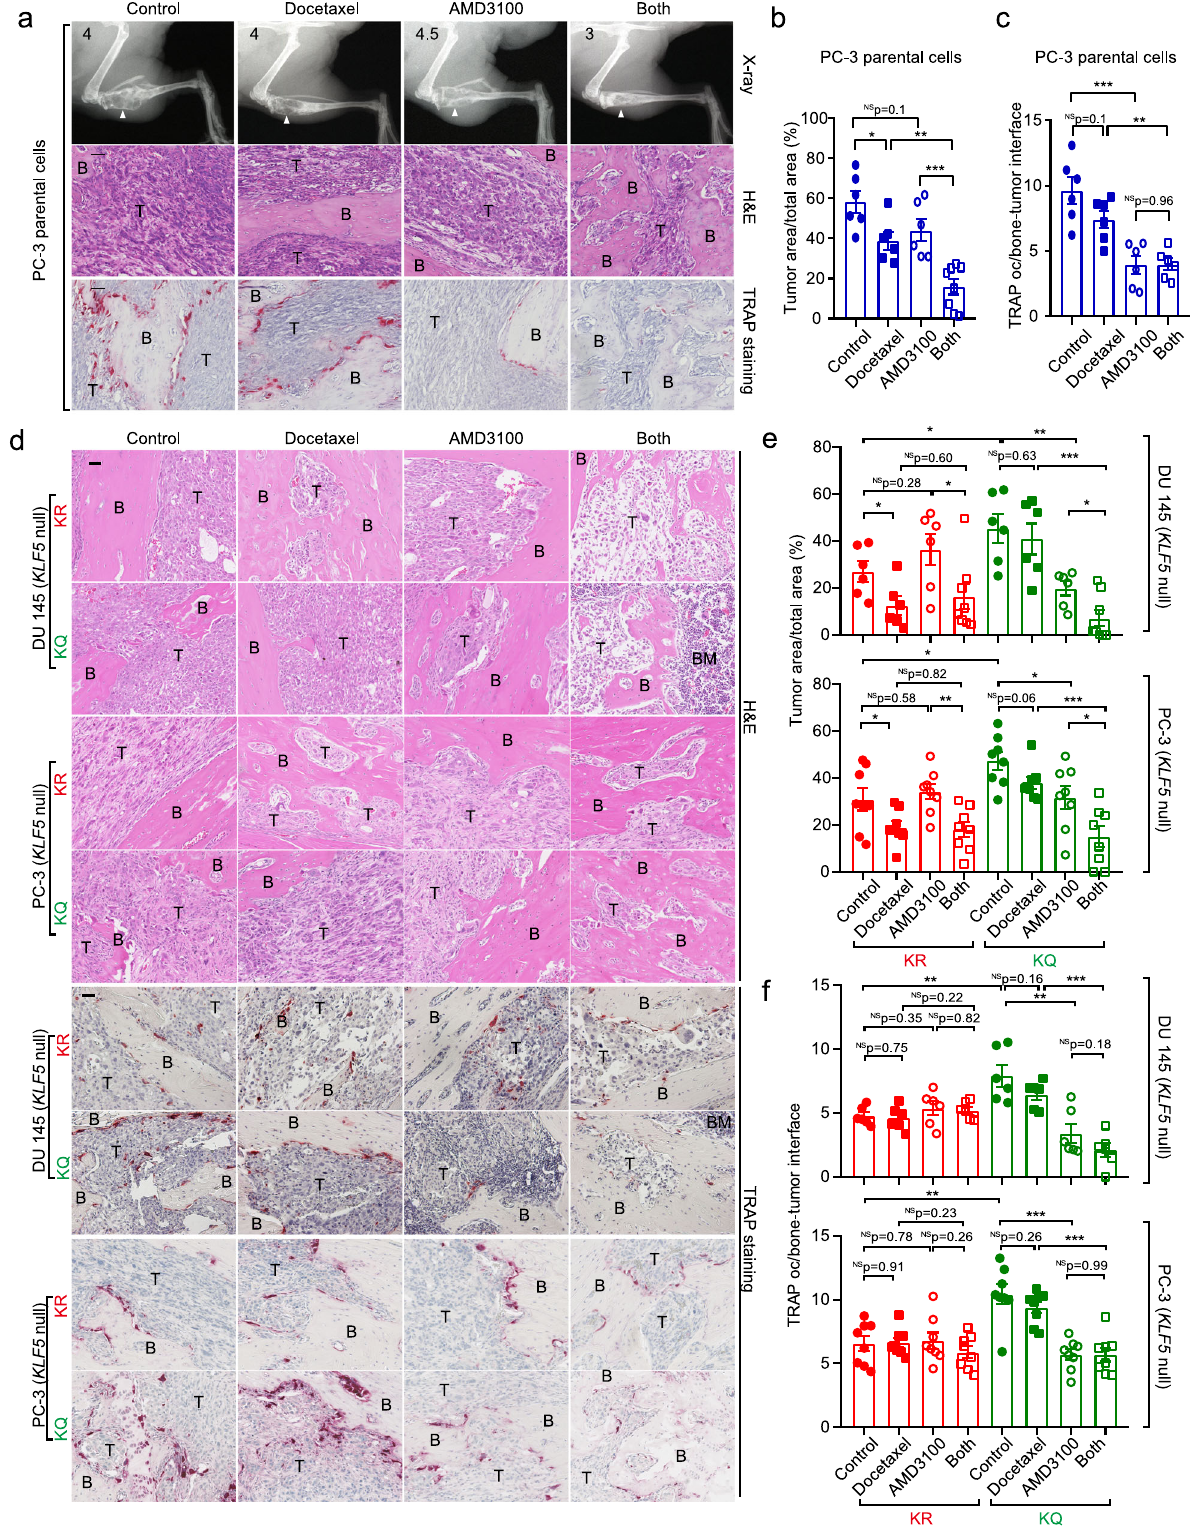
molecules to support their survival and growth; and some of